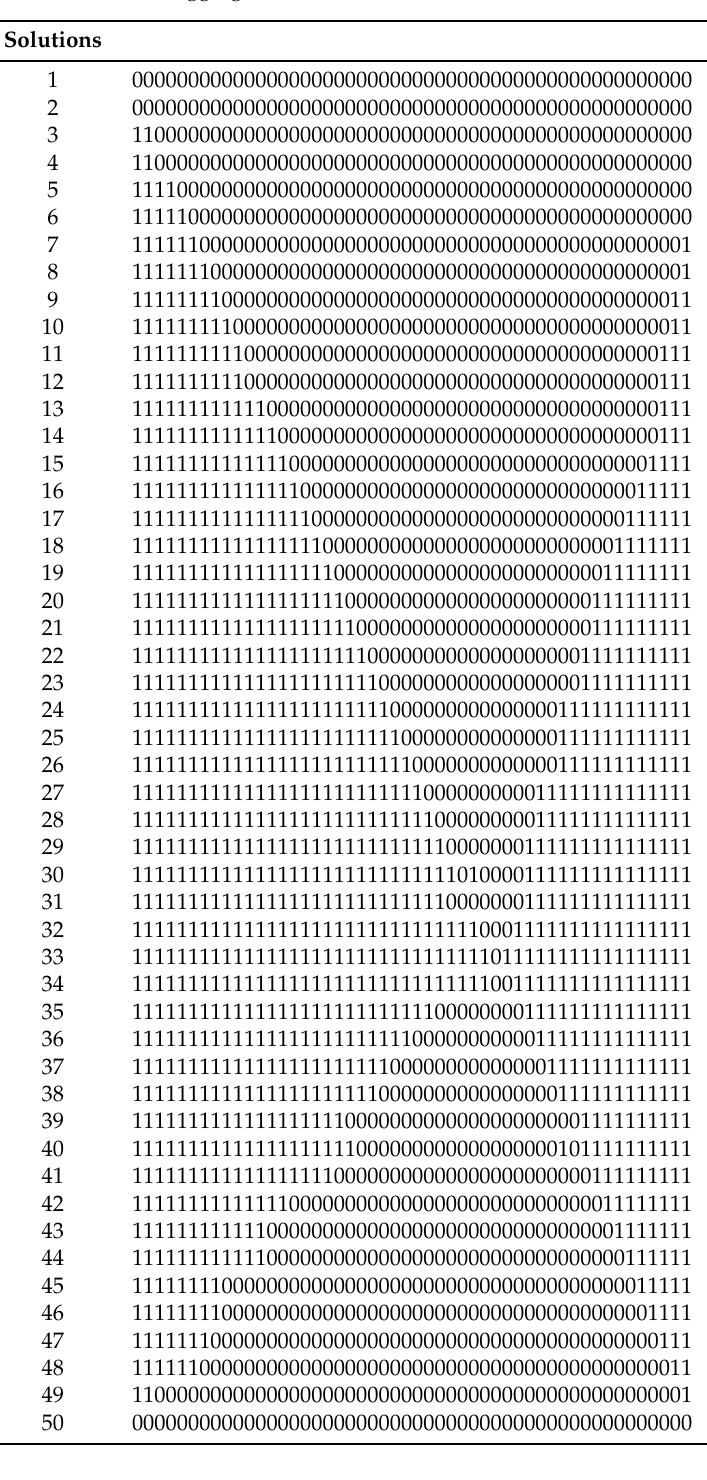
Table 10. Aggregate dominance matrix ( c = 0.1, d =